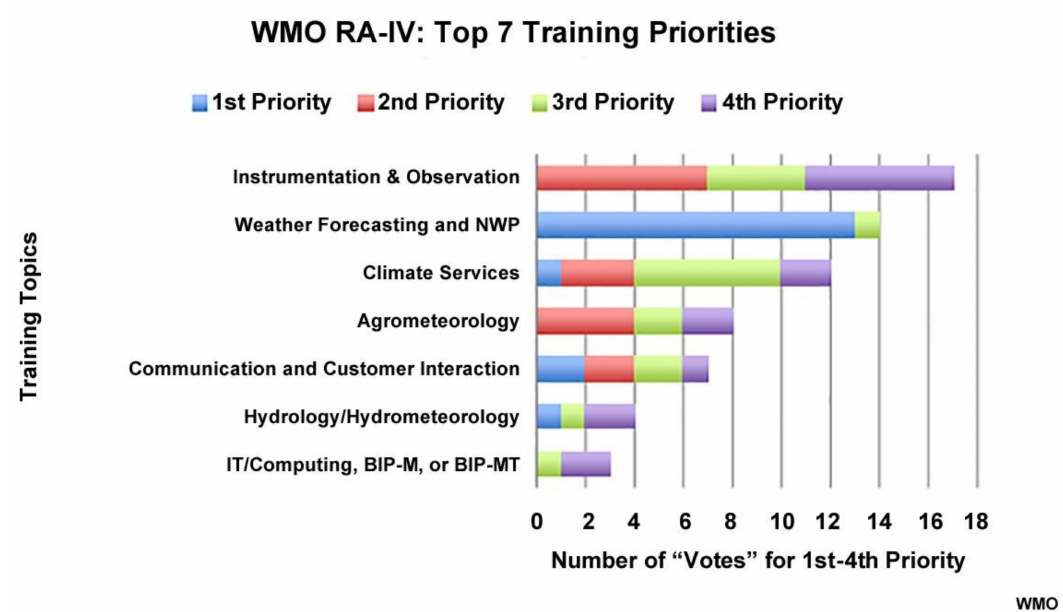
Figure 2. Instrumentation and observation (which includes satellite topics) is the top training priority identified for WMO Regional Association (RA) IV (members include North America, Central America, Caribbean). Communication and customer interaction (key components of decision support services) is in the top five